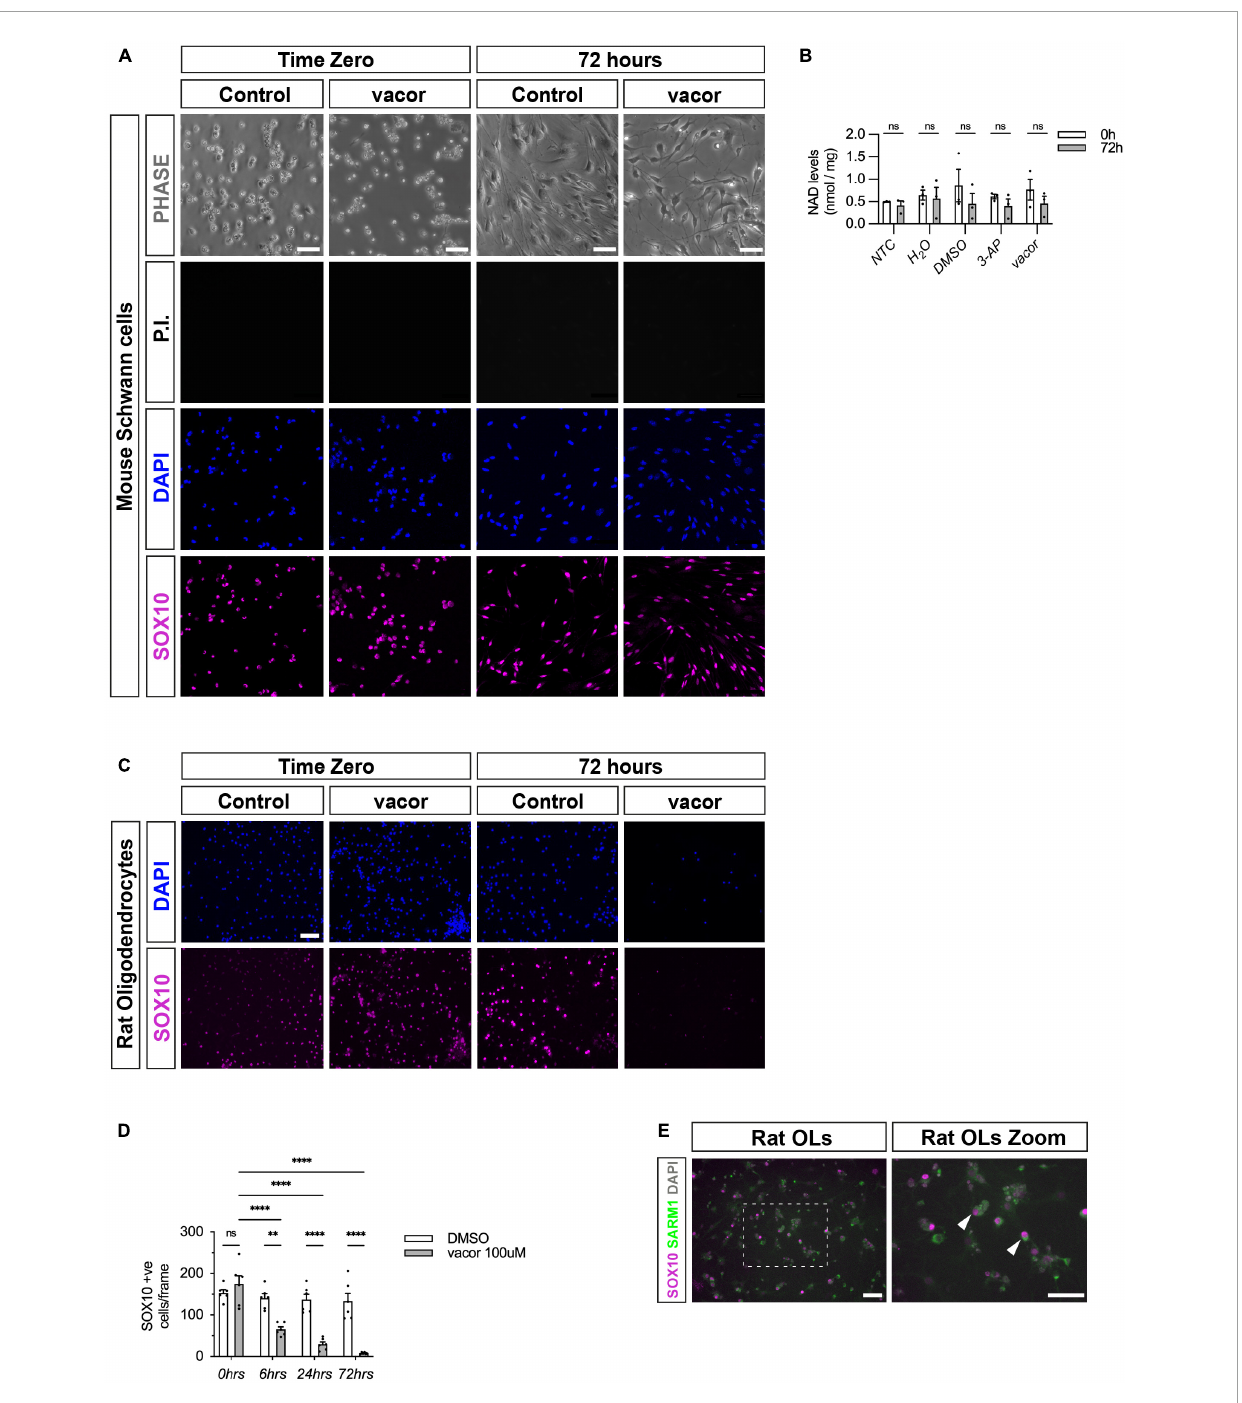
FIGURE3 Cultured oligodendrocytes, but not Schwann cells, are sensitive to specific SARM1 activators. (A) Dissociated and freshly plated P2 mouse Schwann cells cultured in DMSO or 100 µ M vacor for 72 h show no cell death, judged by propidium iodide (P.I.) and DAPI nuclear staining and SOX10 immunocytochemistry. 96.4% ± 0.3 SOX10 positive cells survived after 72 h 100 µ M vacor treatment (mean and SEM, n = 3: two-four mice, each from three litters producing three separate cultures, p = 0.53). Scale bar 25 µ m. (B) Intracellular NAD + levels do not change in Schwann cells when treated for 72 h with either 250 µ M 3-AP (mean and SEM of Time zero (TZ) 0.61 ± 0.05 and 72 h 0.4 ± 1.15, n = 3, p = 0.63) or 100 µ M vacor (mean and SEM of TZ 0.76 ± 0.23 and 72 h 0.46 ± 0.16, n = 3, p = 0.63) compared to control conditions (mean and SEM of H 2 0: TZ 0.64 ± 0.1, 72 h 0.56 ± 0.25, n = 3, p = 0.81; mean and SEM of DMSO: TZ 0.85 ± 0.36, 72 h 0.45 ± 0.22, n = 3, p = 0.61). (C) Rat oligodendrocytes cultured in DMSO or 100 µ M vacor for 72 h demonstrate substantial cell death judged by DAPI nuclear staining and SOX10 immunocytochemistry ( n = 5: one rat from five litters producing five separate cultures). Scale bar 50 µ m. (D) Quantification of SOX10 positive oligodendrocyte cell survival in response to 100 µ M vacor treatment compared to DMSO control cultures. After six, 24 and 72 h of 100 µ M vacor treatment, 47.9% ± 6.5, 21.6% ± 4.5 and 6.5% ± 1.2 of SOX10 expressing cells survived respectively (mean and SEM, n = 5, p = 0.02, p < 0.0001, p < 0.0001 respectively). (E) Cultured rat oligodendrocytes (OLs; SOX10 positive) contain substantial SARM1 protein using a polyclonal anti-SARM1 antibody generated by Y-PH. Zoomed in area (indicated by dashed box). Arrowheads indicate SOX10 positive SARM1 positive cells. Scale bars 50 µ m. ∗∗ P < 0.01, ∗∗∗∗ P <